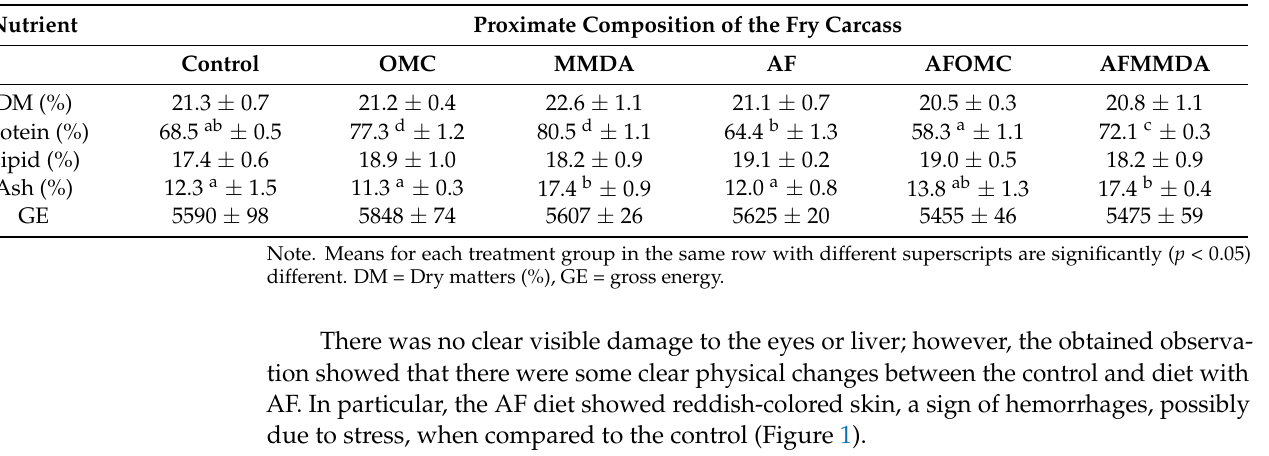
Table 3. Carcass composition (% on dry weight basis) of the fry.